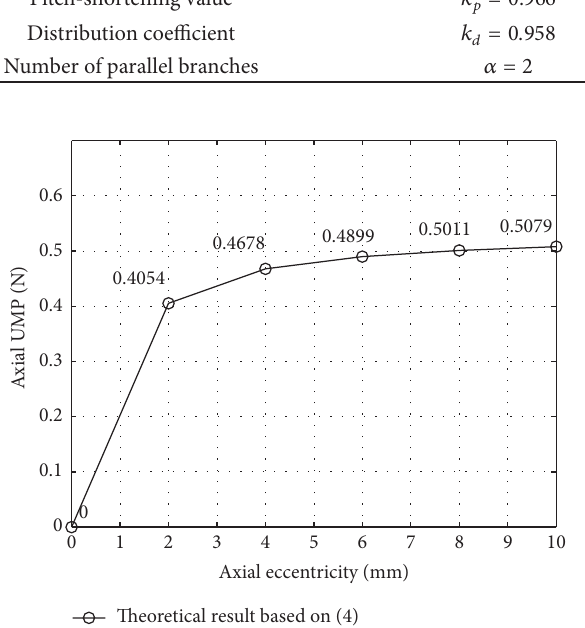
Figure 3: Relationship between AAGE and UMP based on